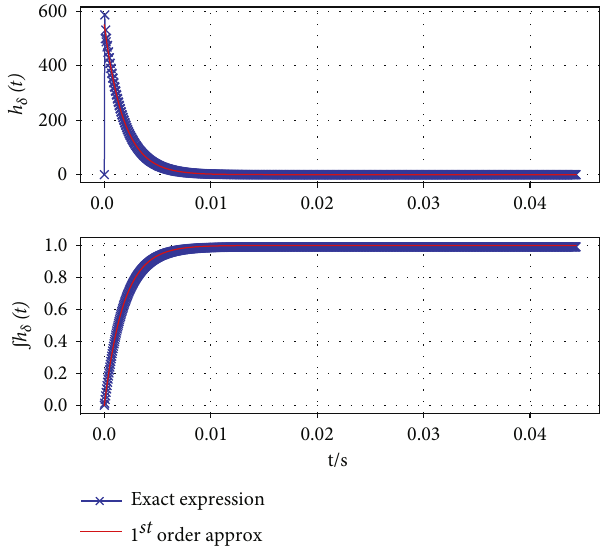
Figure 6: Impulse (top) and step (bottom) response comparison: equation (61) in blue vs. equation (57) in